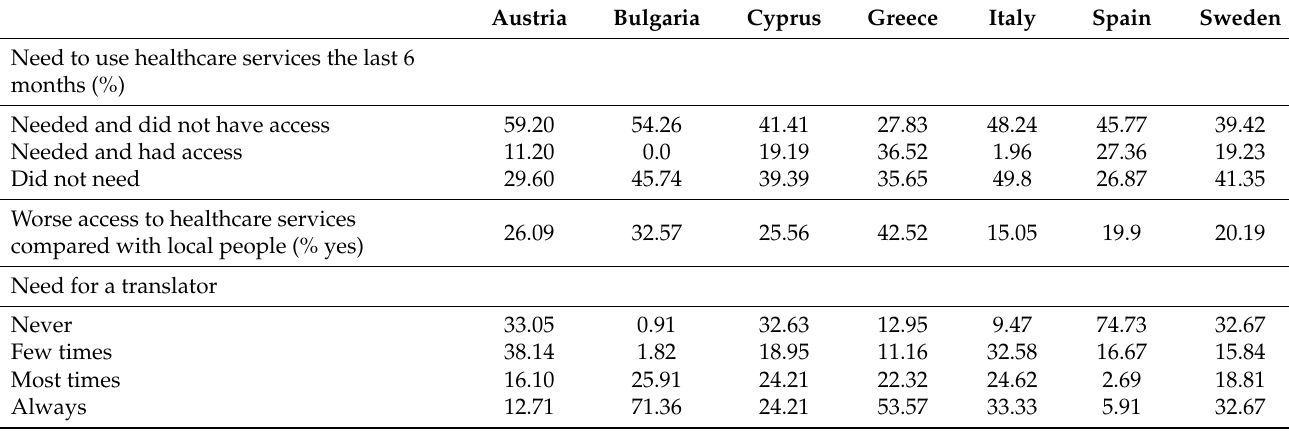
Table 4. Access to healthcare services and requirement of a translator by country of interview. Migrants and refugees from Germany, France, and Malta were excluded from the analysis.